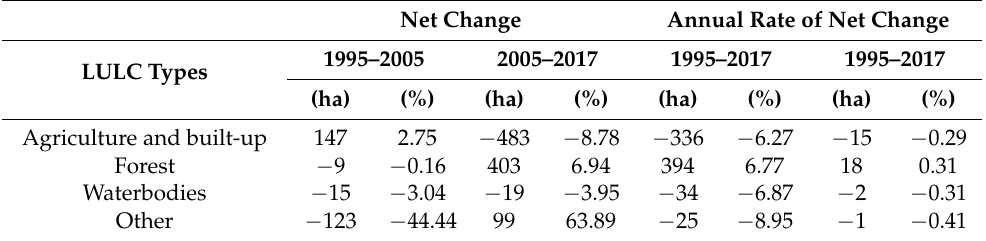
Table 6. Change statistics (in ha and %) of LULC in Phewa Lake Watershed from 1995 to 2017. Net